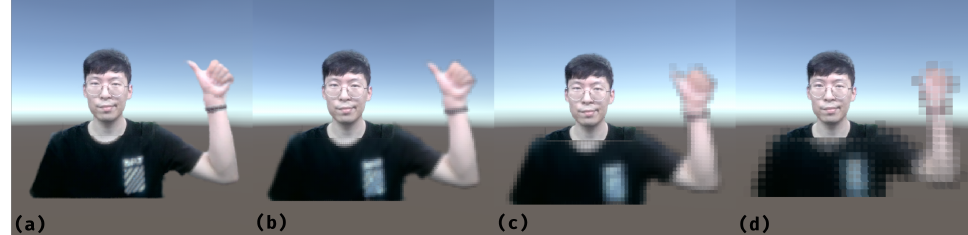
Figure 12. Pixel avatars with different resolutions: ( a ) 320 × 240 resolution pixel avatar; ( b ) 160 × 120 resolution pixel avatar; ( c ) 80 × 60 resolution pixel avatar; ( d ) 40 × 30 resolution pixel